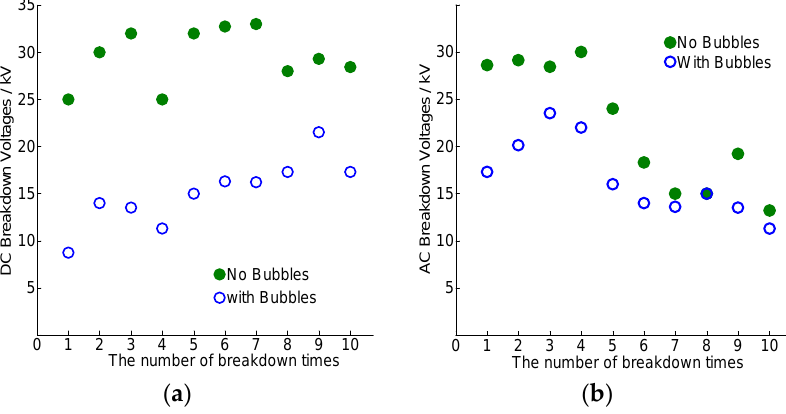
Figure 7. The breakdown voltages of the oil-impregnated pressboard. ( a ) The DC breakdown voltages; and ( b ) the AC breakdown voltages (effective values). Table 4. Statistics of the oil-impregnated pressboard breakdown voltages (BDV).